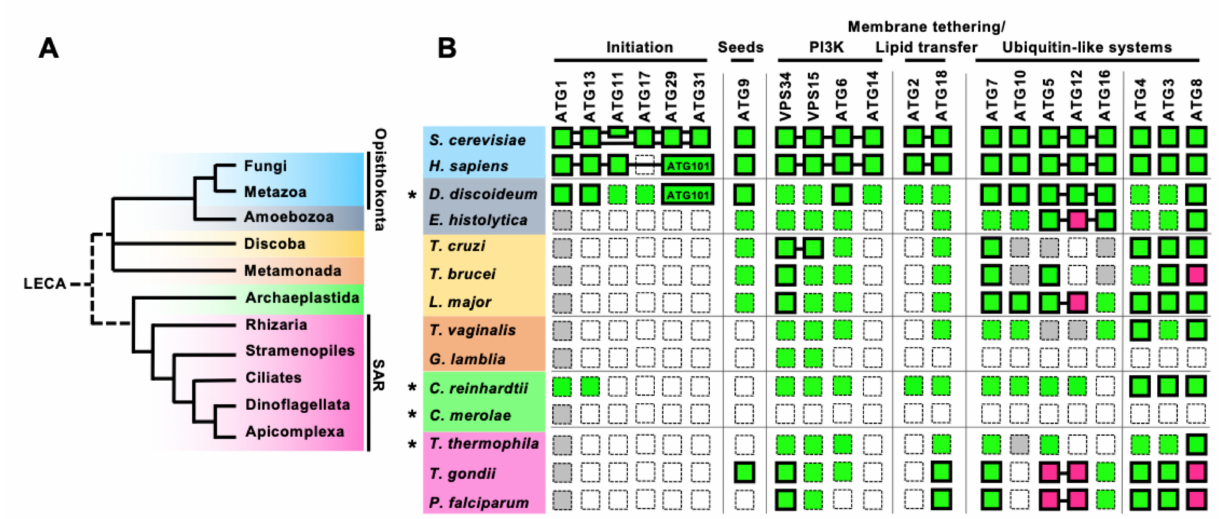
Figure 3. Conservation of the core ATGs in parasitic protists. ( A ) A simplified phylogenic tree of eukaryotes based on [21,22]. Fungi and Metazoa both belong to the Opisthokonta phylogenetic group. SAR includes Stramenopiles, Alveolata (Ciliates, Dinoflagellate, and Apicomplexa), and Rhizaria. ( B ) Conservation of the core ATG machinery in parasitic protists, compared with those of yeast, human, and free-living protists (shown by an asterisk). Conserved genes are shown in green and missing genes are shown in white. Genes with low overall homology to yeast Atgs, but with conserved specific motifs or domains are shown in gray. Magenta indicates the conservation of a functional homolog with atypical features. Proteins that have been functionally analyzed are enclosed by bold lines. The proteins with proven interactions are connected to each other by a line, including the atypical ATG12–ATG5 interaction characterized in Apicomplexa. S. cerevisiae has two scaffold proteins in the ATG1 complex, ATG11 and ATG17, while H. sapiens has one scaffold protein, FIP200 which is a homolog of ATG11. H. sapiens has ATG101 instead of ATG29 and ATG31. Conservation and function of ATGs in Dictyostelium discoideum are reviewed in [23,24], in [25] for Chlamydomonas reinhardtii (green algae) and Cyanidioschyzon merolae (red algae), and in [26] for Tetrahymena thermophila . Additional searches for members of the poorly conserved initiation complex, ATG11/FIP200, ATG17, and ATG29/ATG31 (ATG101), were conducted for C. reinhardtii , C. merolae , and T. thermophila , using human or yeast homologs as